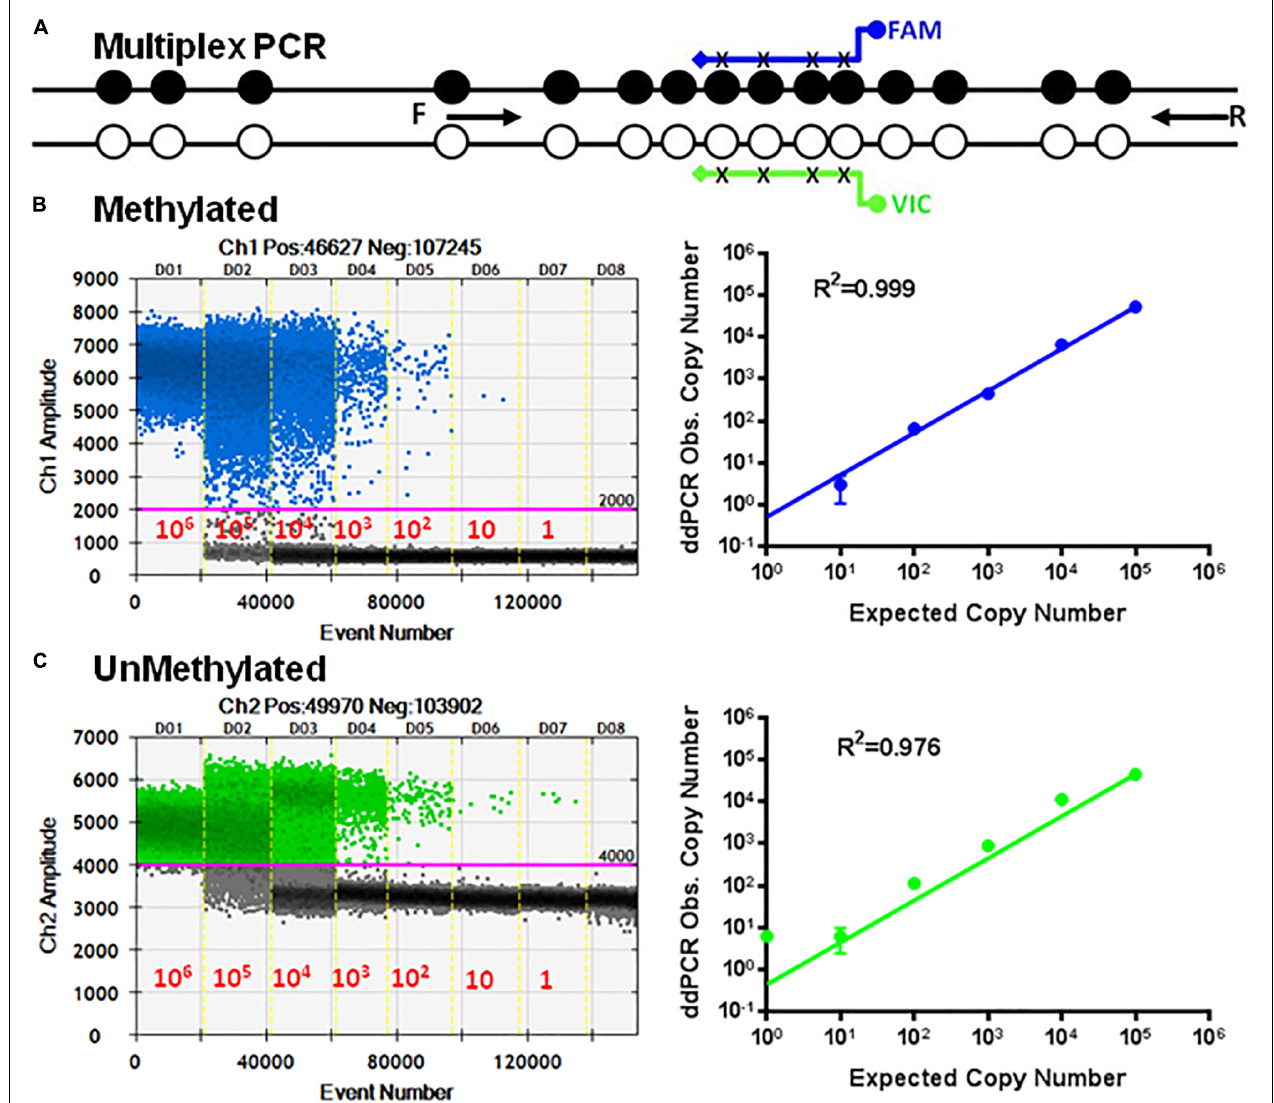
FIGURE 4 | Multiplex ddMSP assay. (A) Schematic illustration of the TSDR of FOXP3 showing two general TSDR primers with probes for each of the methylated and unmethylated CpGs that interrogates four CpGs of TSDR. Standard curves of methylated (B) and unmethylated (C) FOXP3 TSDR in the same reaction. ddPCR using serially diluted mixed plasmids (10 6 –1 copy/reaction). Standard curves with linear regression analysis for methylated and unmethylated targets. The data shown are the average with standard deviation (SD) of three